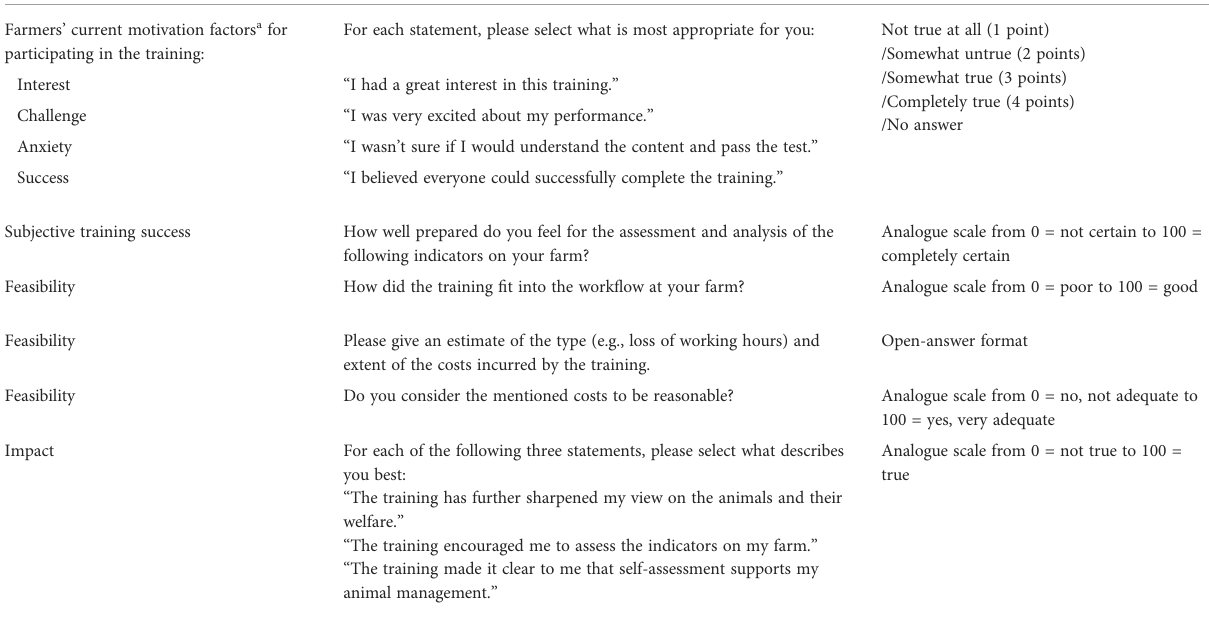
TABLE 2 Items of the online